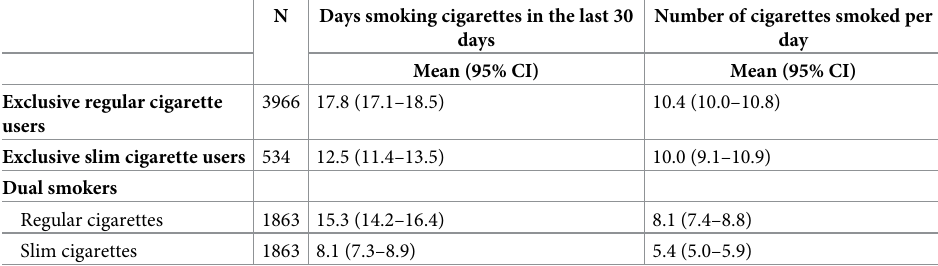
Table 2. Level of cigarette consumption among current smokers.